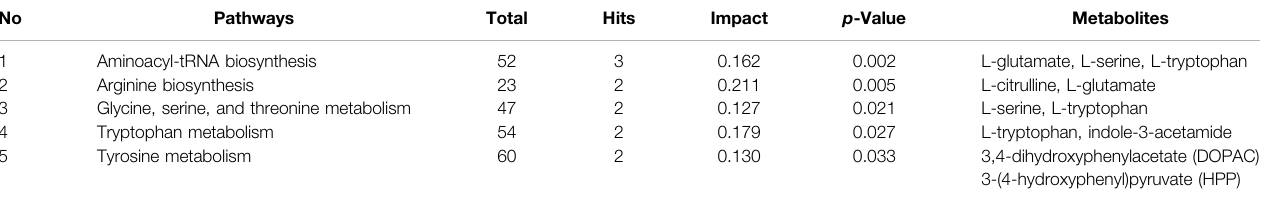
TABLE 1 | Five key metabolic pathways and the corresponding differentially expressed metabolites in